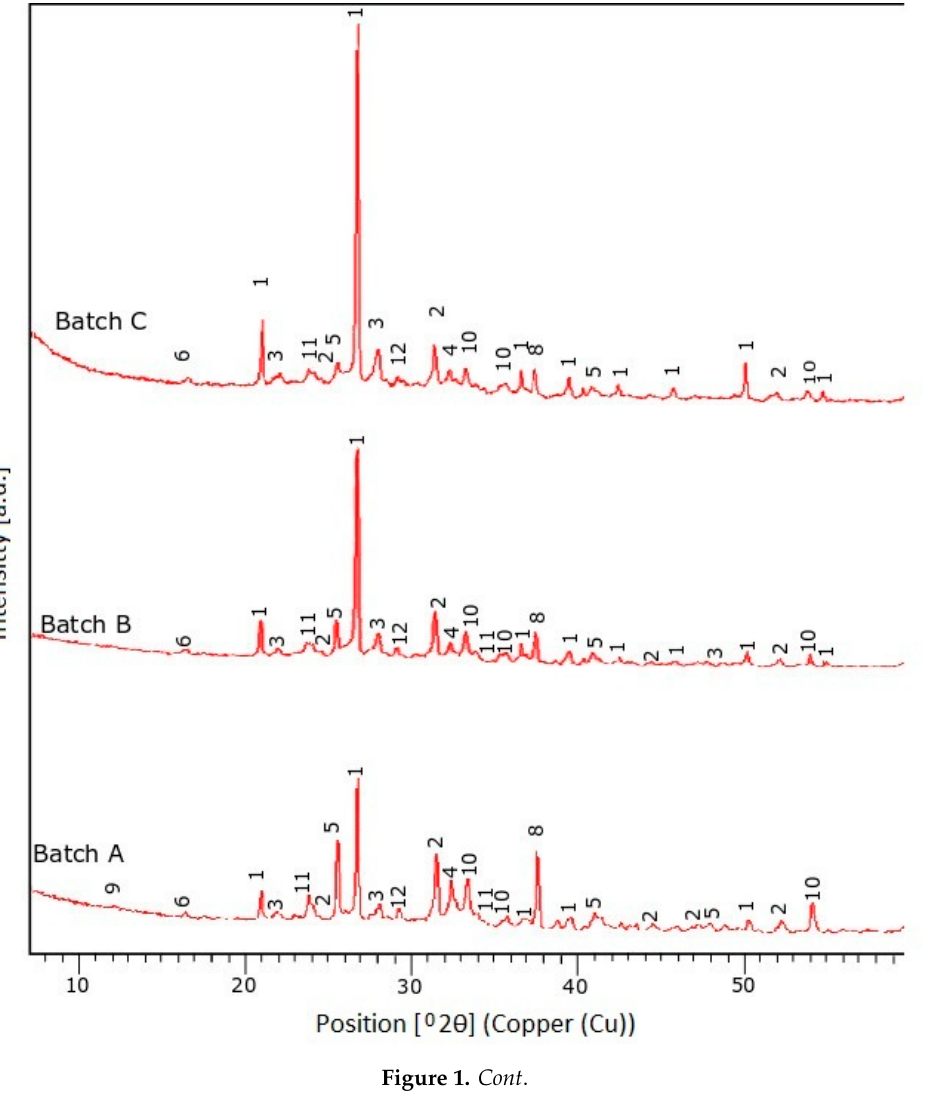
Figure 1. The X-ray diffraction (XRD) pattern of CFA batch A, B, C.